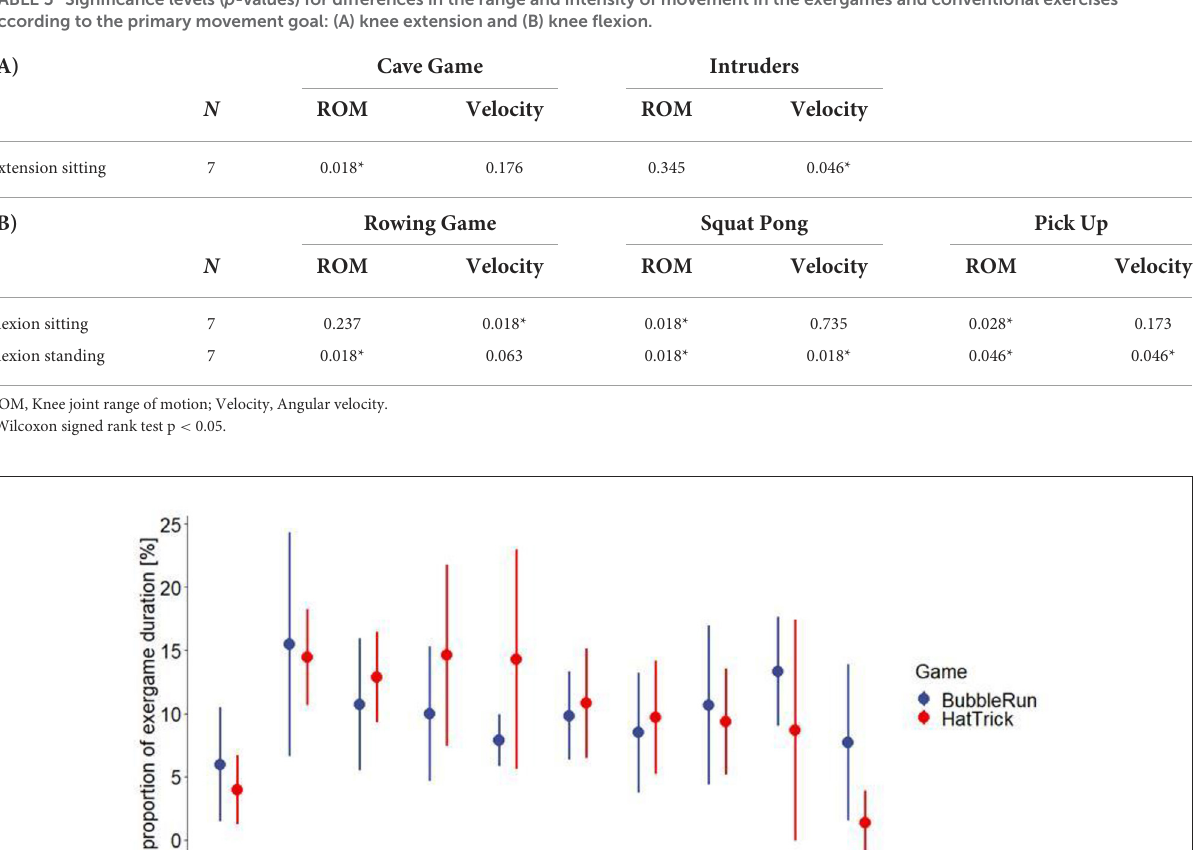
TABLE 5 Significance levels ( p -values) for differences in the range and intensity of movement in the exergames and conventional exercises according to the primary movement goal: (A) knee extension and (B) knee flexion.